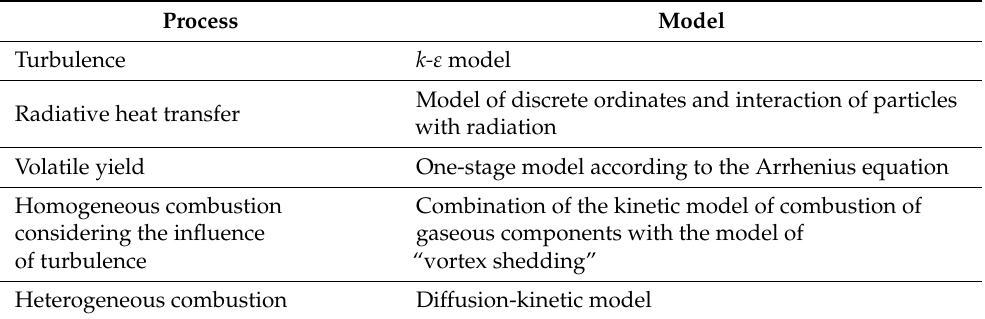
Table 5. Numerical models.